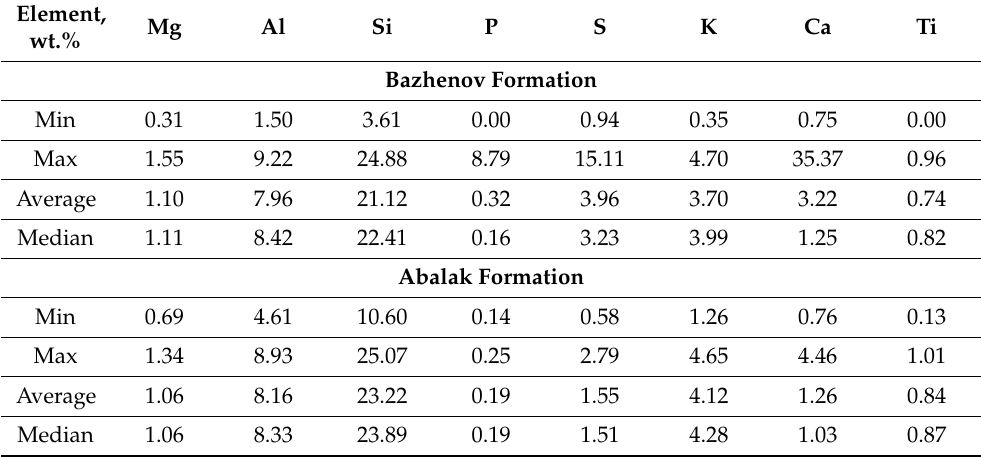
Table A1. Summary of element composition measured by portable XRF-spectrometer.